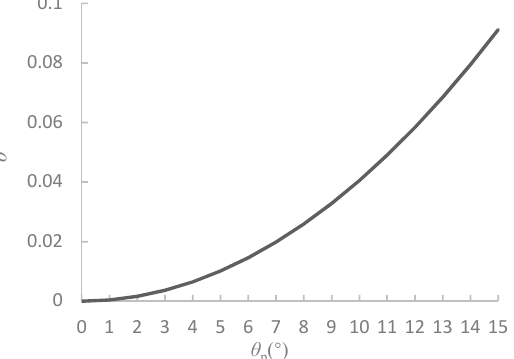
Figure 5. δ versus θ p when upper and lower divergence angles are consistent.